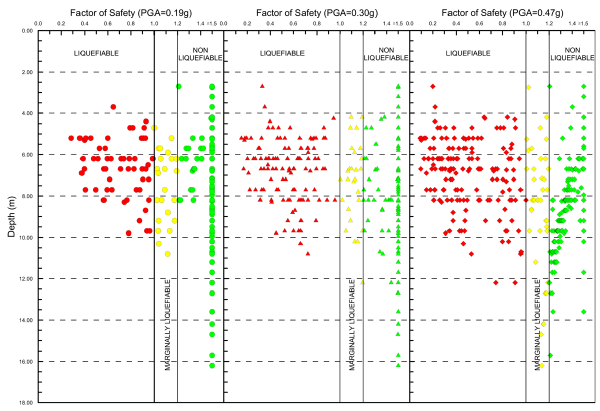
Fig. 10. Variation of safety factor versus liquefaction depth